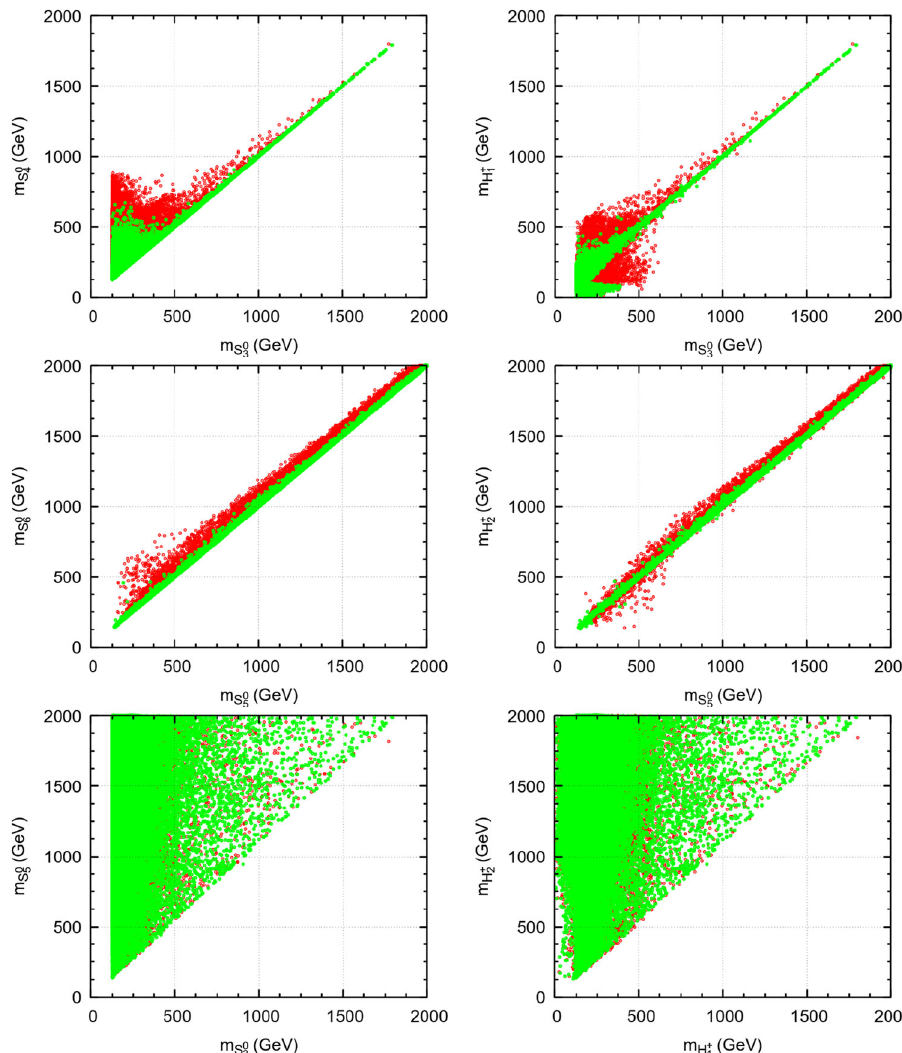
Fig. 1 Left panel: Relation between m and m . Right S 0 3 S 0 4 panel: Relation between m S 0 3 and m . Color conventions: H + 1 No cuts (red); with cuts (green)